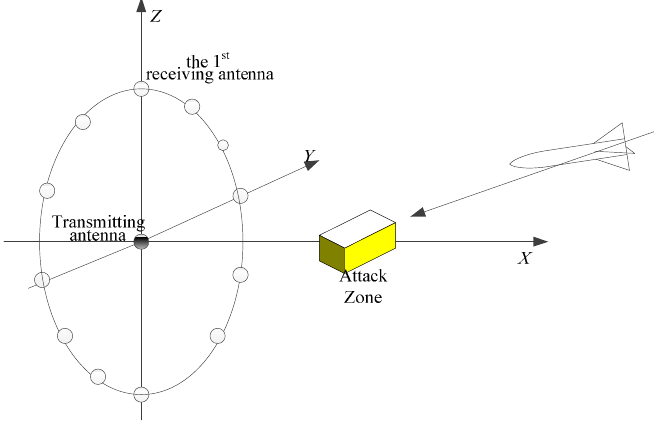
Figure 1. SIMO-SAR scenes of high-speed moving target SIMO-SAR scenes in short-range.